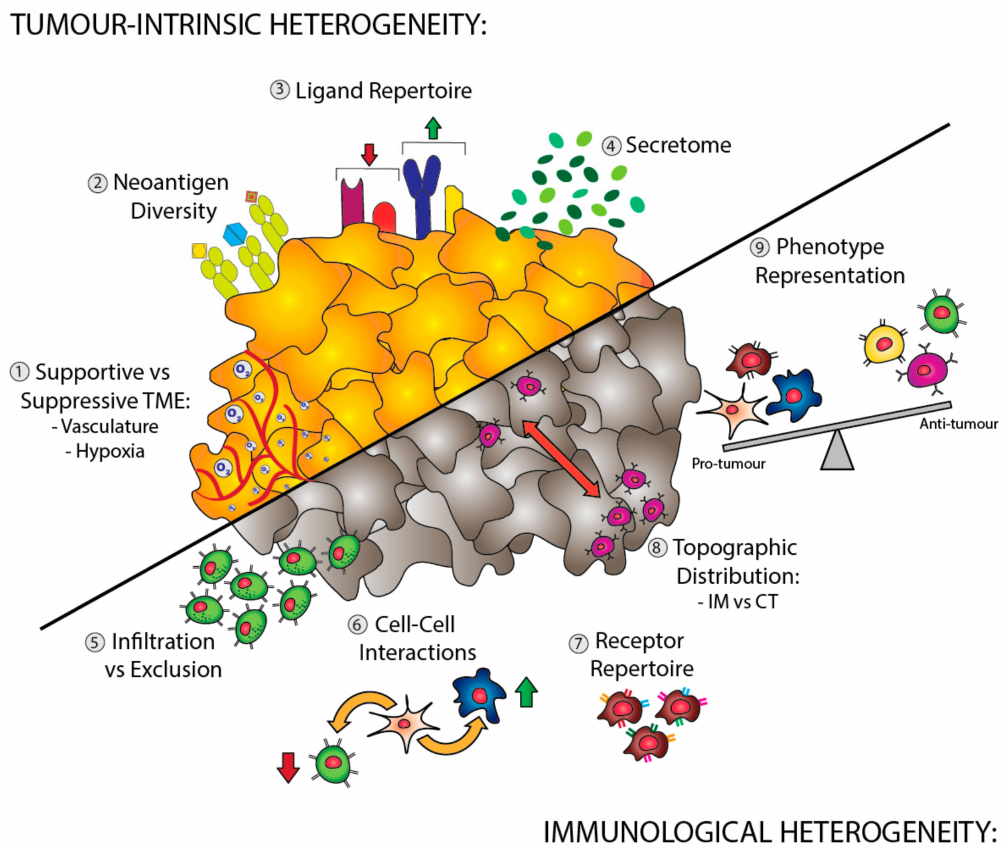
Figure 1. Tumor and immunological heterogeneity. Tumor-intrinsic drivers of heterogeneity (upper left) include diversity in: the degree of tumor vascularization or hypoxia ( 1 ), which determines whether the local tumor microenvironment (TME) will support or suppress anti-tumor immune cells; the variable expression of neoantigens ( 2 ) and ligands ( 3 ), which facilitate interaction with various immune cell types; and the secretion of soluble factors ( 4 ) (which may also be produced by the immune cells themselves) that may promote or restrain the action of nearby immune cells. Immune cell contributions to heterogeneity (bottom right) include: the type and density of infiltrating versus excluded immune cells ( 5 ); modulatory interactions between co-localised immune cell types ( 6 ); the balance of activating versus inhibitory receptors ( 7 ); e ff ector cell distribution between the invasive margin (IM) and central tumor (CT) ( 8 ); and the overall balance between pro- and anti-tumor e ff ectors ( 9